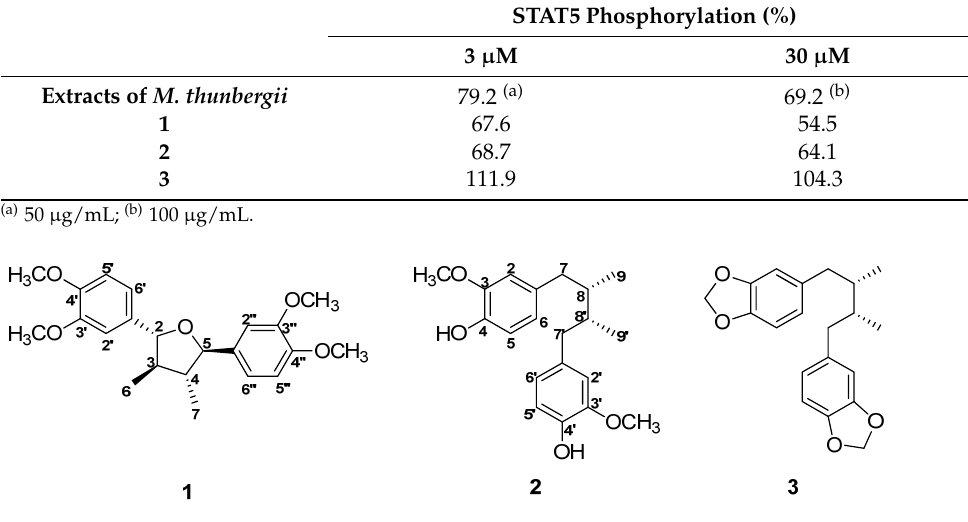
Table 1. The effect of isolated compounds on STAT5 phosphorylation by flow cytometry. STAT5 Phosphorylation (%) 3 µM 30 µM Extracts of M. thunbergii